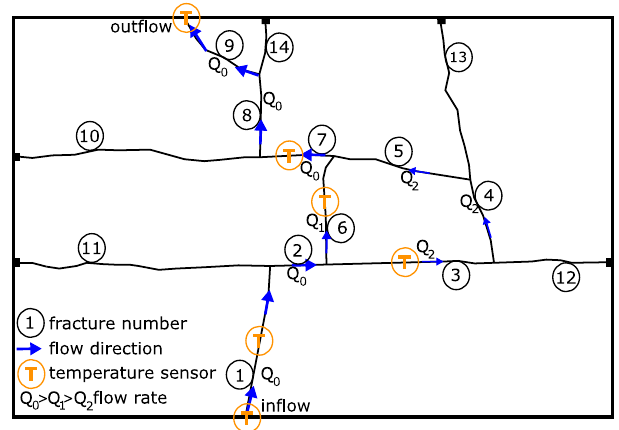
Fig.1|Experimentalsetup. Fracturenetworkofthebench-scaleexperimentswith fractures1to9contributingto fl owandfractures10to14withdeadends.Thetotal Q Q fl owpathsthroughfracture6 fl owrate Q 0 issplitinto 1 and 2 forthetwoparallel and fractures 3 to 5. Water temperature is recorded at in- and out fl ow. Rock tem- perature is recorded in fractures 1, 3, 6 and